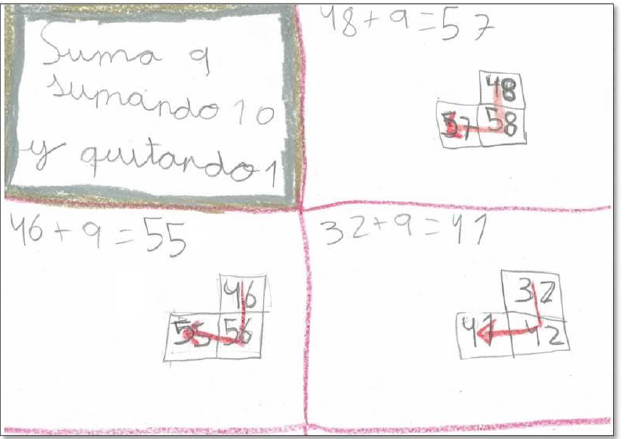
Figure 19. Operation and its representation of movement on the panel.